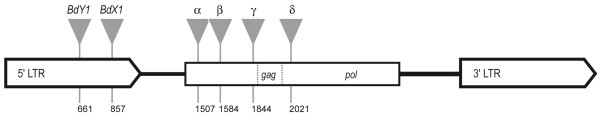
Locations of the solo-LTRs within the RLC-sequence. Schematic representation illustrating the locations of the paralogous solo-LTRs. The position numbers at which each insertion begins are in reference to the consensus sequence of RLC_XXX_Bryonia (RLC-sequence), the common Copia-like element in which the solo-LTRs are found. The coding region begins at bp 1131.